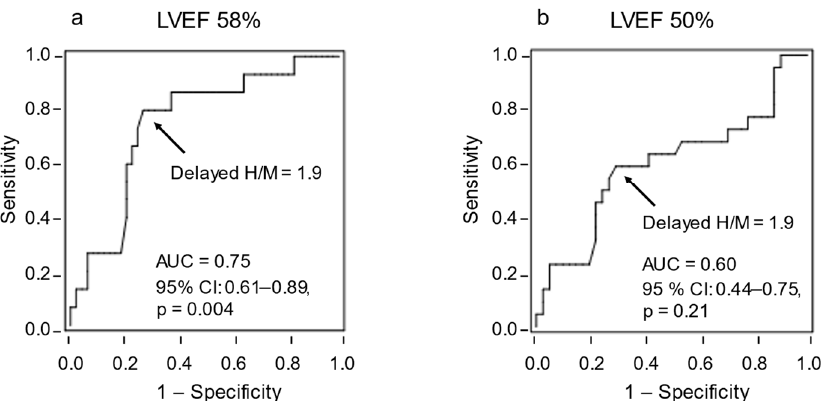
Figure 3. The ability of the delayed heart/mediastinum (H/M) ratio to identify LVEF of 58% or 50% was evaluated using a receiver operating characteristic (ROC) curve analysis, in which the area under the curve (AUC) and 95% confidence interval (CI) were calculated. ( a ) The ROC curve for the delayed H/M ratio for predicting a left ventricular ejection fraction (LVEF) of 58% was 0.75 (95% CI 0.61–0.89, p = 0.004). From this analysis, a delayed H/M ratio of 1.9 had a sensitivity and specificity of 80.0% and 72.9%, respectively, for predicting an LVEF of 58%. ( b ) The area under the ROC curve for delayed H/M ratio for predicting an LVEF of 50% was not significant (0.60; 95% CI 0.44–0.75, p = 0.21).